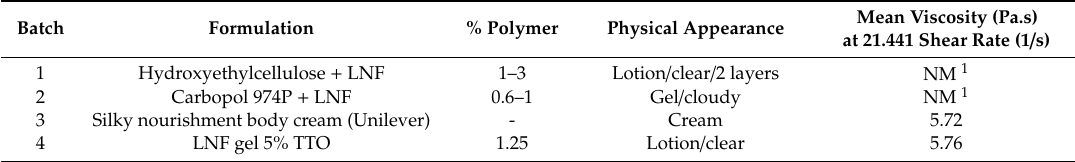
Table 4. Screening and optimization of polymers for LNF